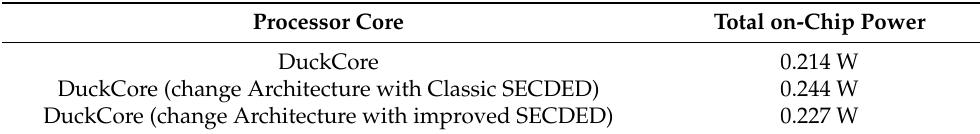
Table 4. Comparison of power consumption under different codes.